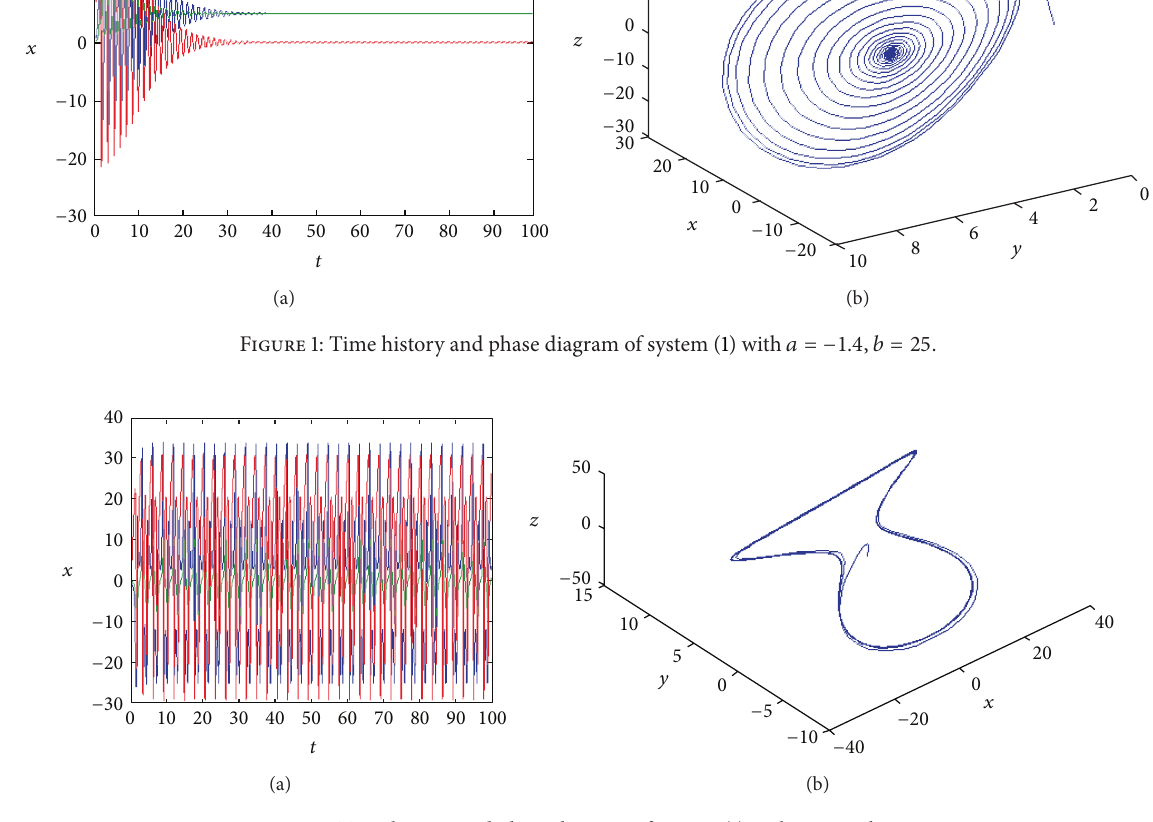
Figure 2: Time history and phase diagram of system (1) with 𝑎 = −1 , 𝑏 = 25